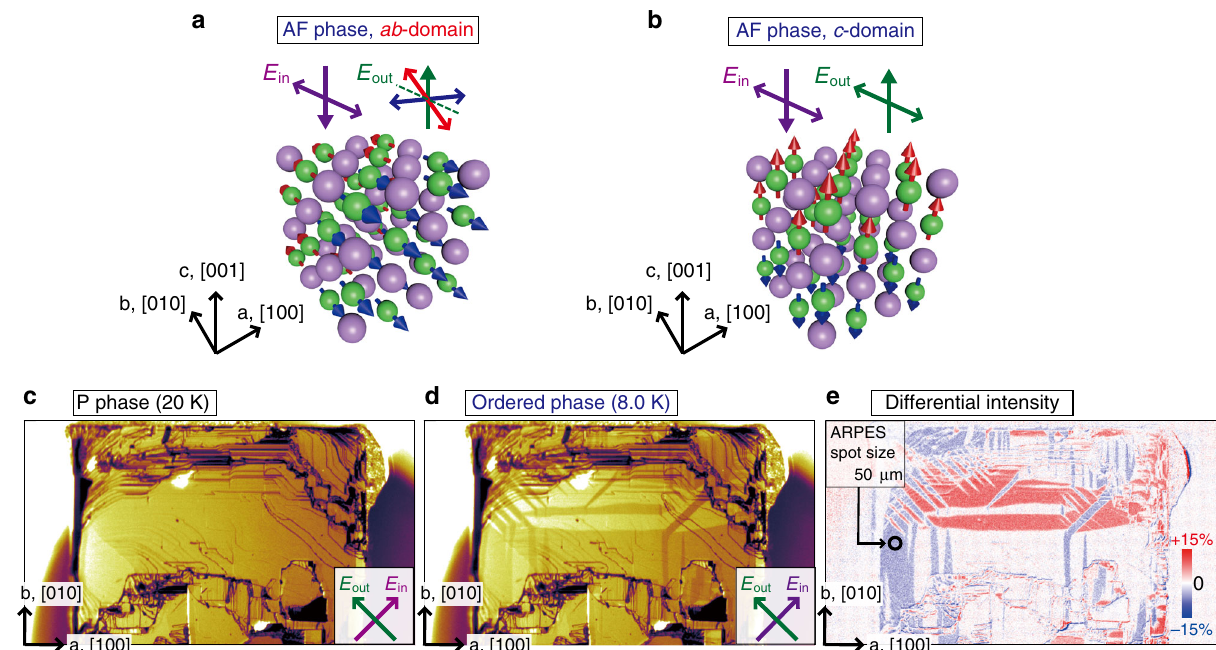
Fig. 2 Polarizing microscope images of CeSb. The uniaxial magnetostructures with different orientation of the 4 f moment along [100] or [010] ( a ab -domain) and along [001] ( b c -domain). The double arrows indicate the optical principal axis of the incident light (purple arrow) and re fl ected light (blue, red and green arrows). Polarizing microscope images of the cleaved (001) surface at c P phase at 20K and d the ordered phase at 8K. These images were taken under crossed Nicols con fi guration that is sensitive to ab -domain but insensitive to c -domain. The differential image presented in e to display the domain distributions. The size of the domain is suf fi ciently large for the spot size of the laser light in our laser-ARPES experiments